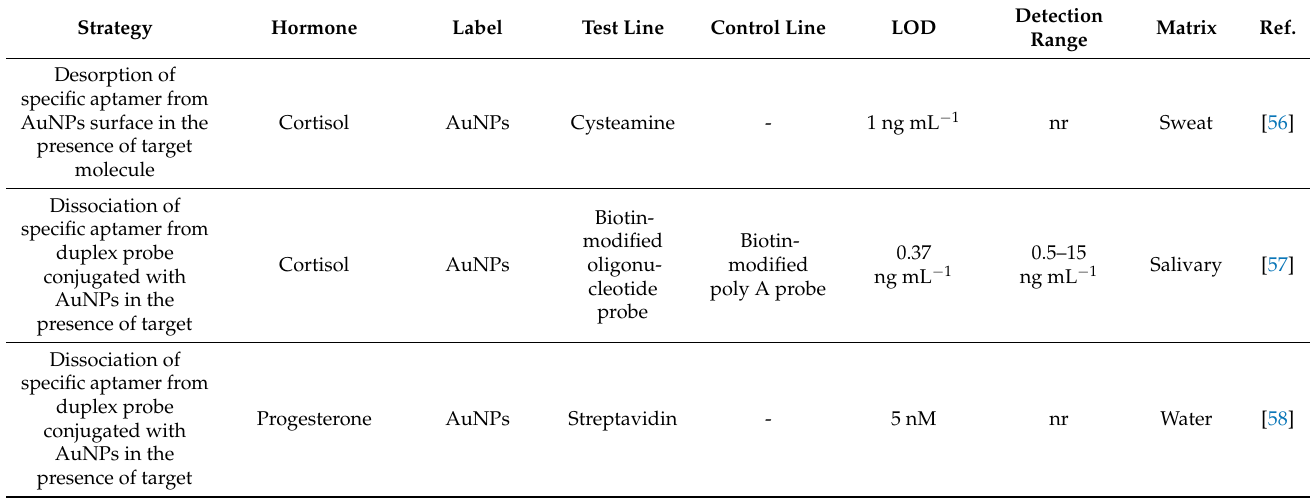
Table 3. Aptamer-based lateral flow assays for detection of